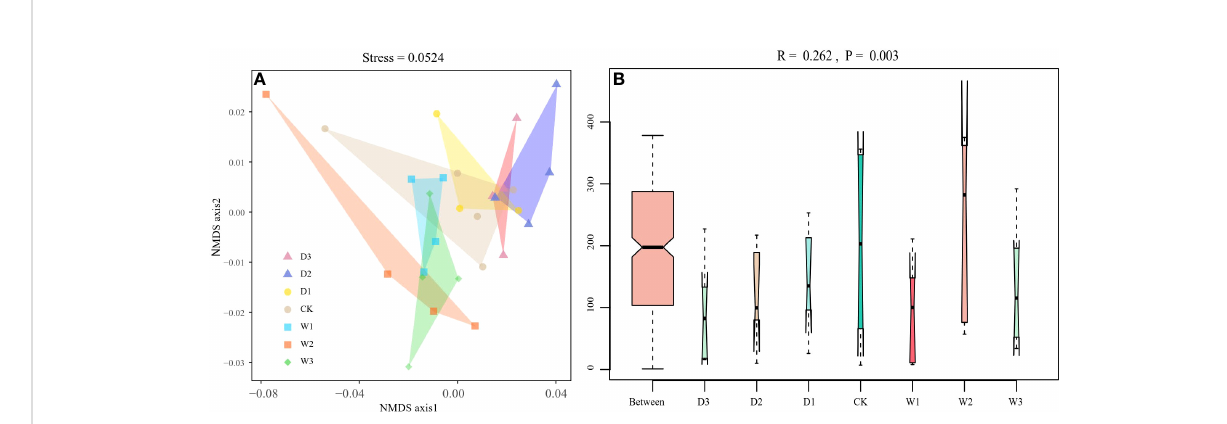
FIGURE 4 Beta diversity of soil bacterial community under seven precipitation gradients in the alpine steppe of Northern Tibet. (A) Non-metric multidimensional scaling (NMDS) analysis. Different shaped dots represent the samples from different alpine grassland types, and the bumps of the samples bound the faces of different colors. (B) Analysis of similarity (ANOSIM). Between re fl ects the differences between groups, and groups D3, D2, D1, CK, W1, W2 and W3 represent the differences within groups.